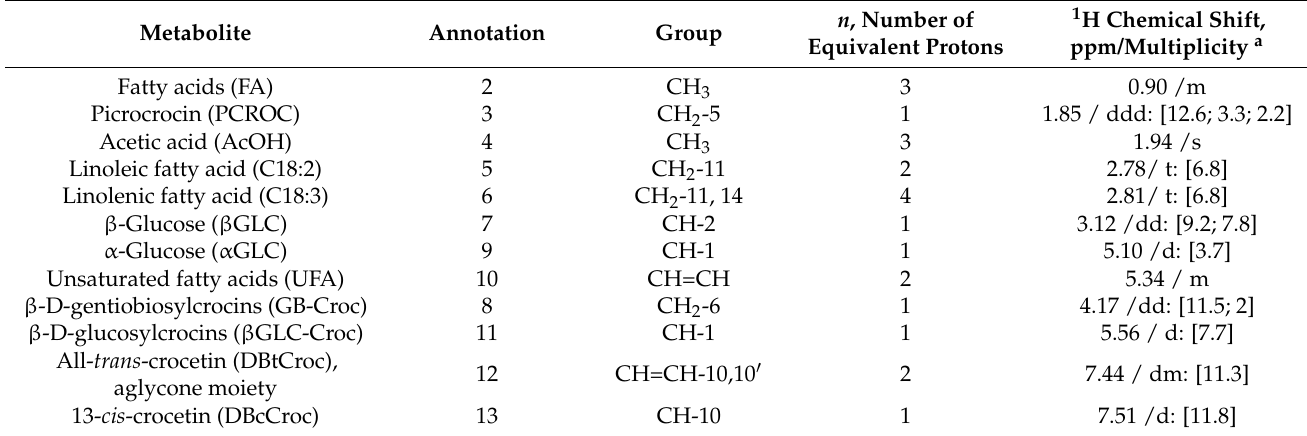
Table 4. Selected 1 H NMR signals in the NMR spectra of saffron